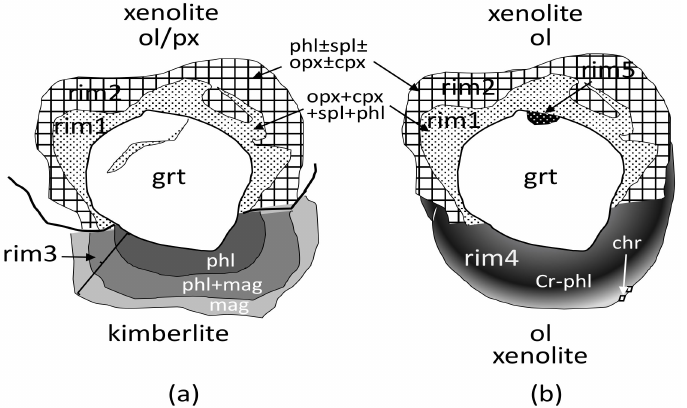
Figure A1. Scheme of the kelyphite rim types, locations, and compositions: ( a ) Rims 1, 2 and 3 surrounding garnets of peridotites or eclogites A, B; ( b ) rims 4 and 5 surrounding garnets of